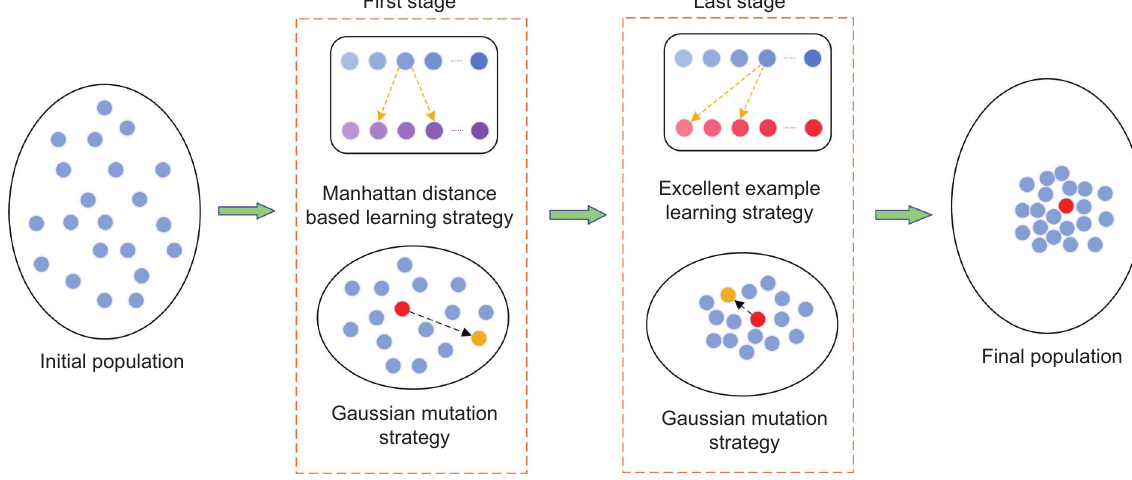
Fig. 1 Frame diagram of